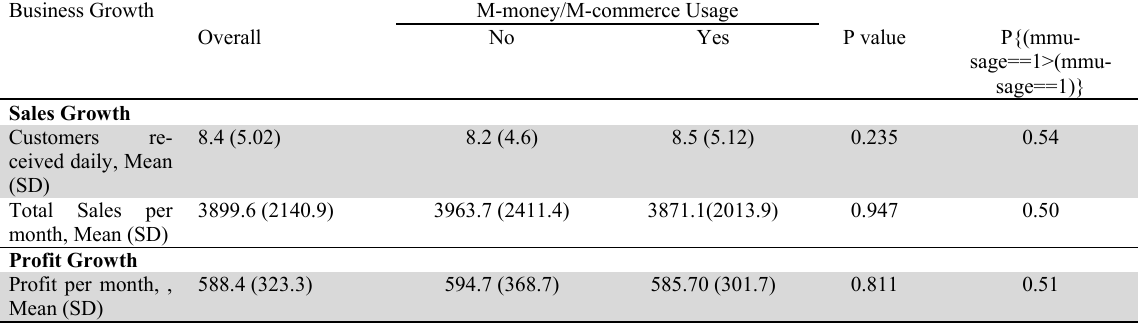
Shows the business growth by M-money and M-commerce Usage Business